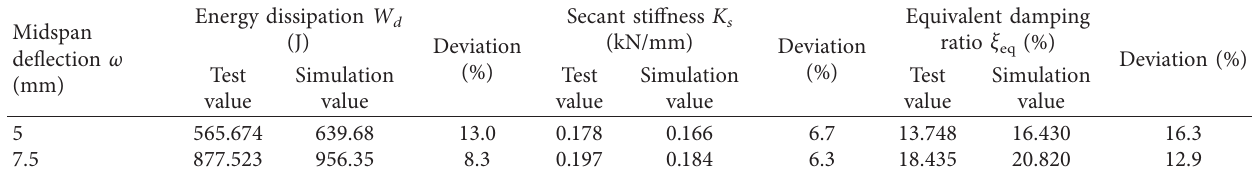
Table 12: Mechanical parameters of the FEM analog value versus test value (SCVF brace with spring S2). Midspan deflection ω